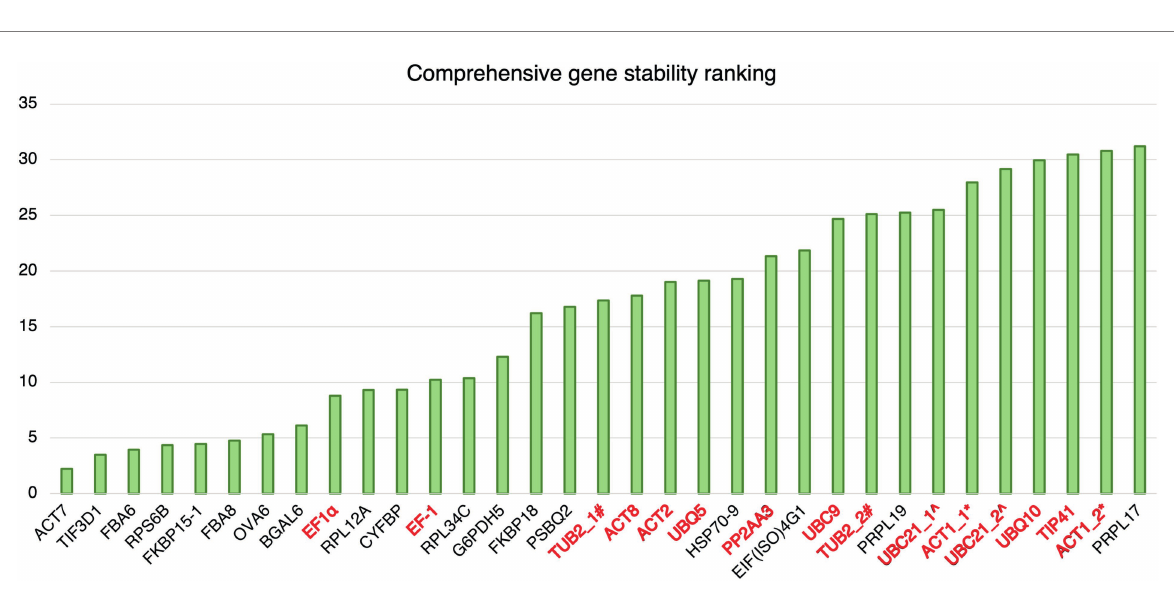
FIGURE 5 Comprehensive gene stability ranking of the predicted reference gene candidates and the commonly used reference gene for Pst DC3000 inoculation. The stability ranking was generated using the RefFinder. A lower stability ranking refers to a higher stability of the reference gene. Gene names in black: candidate reference genes reported in this study; gene names in red: reference genes commonly used in previous studies. # TUB2_1 and TUB2_2 refer to two different primer pairs for TUB2 (Wu et al., 2019; Gao et al., 2022). ^ UBC21_1 and UBC21_2 refer to two different primer pairs for UBC21 (Cuéllar Pérez et al., 2014; Gao et al., 2022) . *ACT1_1 and ACT1_2 refer to two different primer pairs for ACT1 (Kim and Hwang, 2014; Zhang et al.,